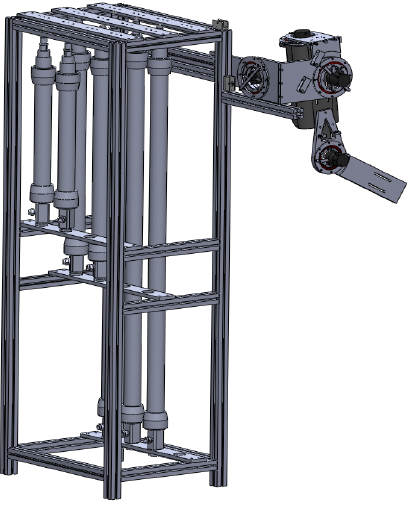
Figure 3. Schematic diagram of the complete structure of the robotic arm.